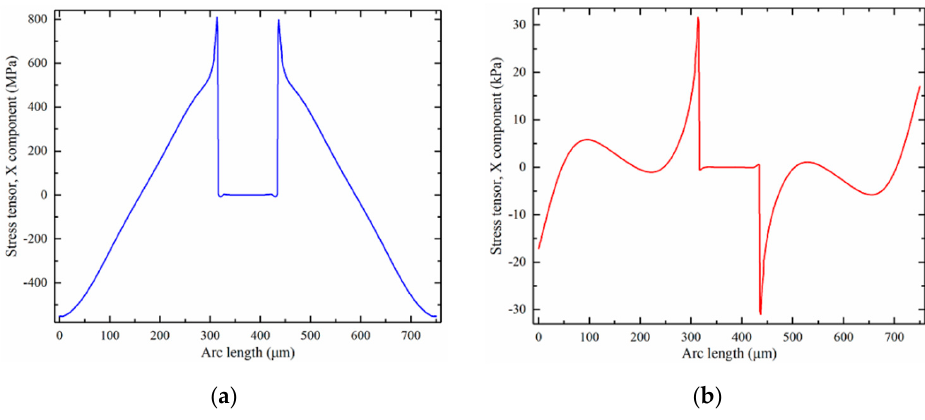
Figure 13. Stress tensor curve of beam: ( a ) buckling stress curve; ( b ) variation in post-buckling stress curve and buckling stress.